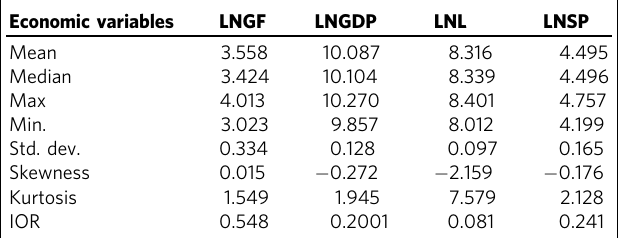
Table 1 Descriptive statistics of variables